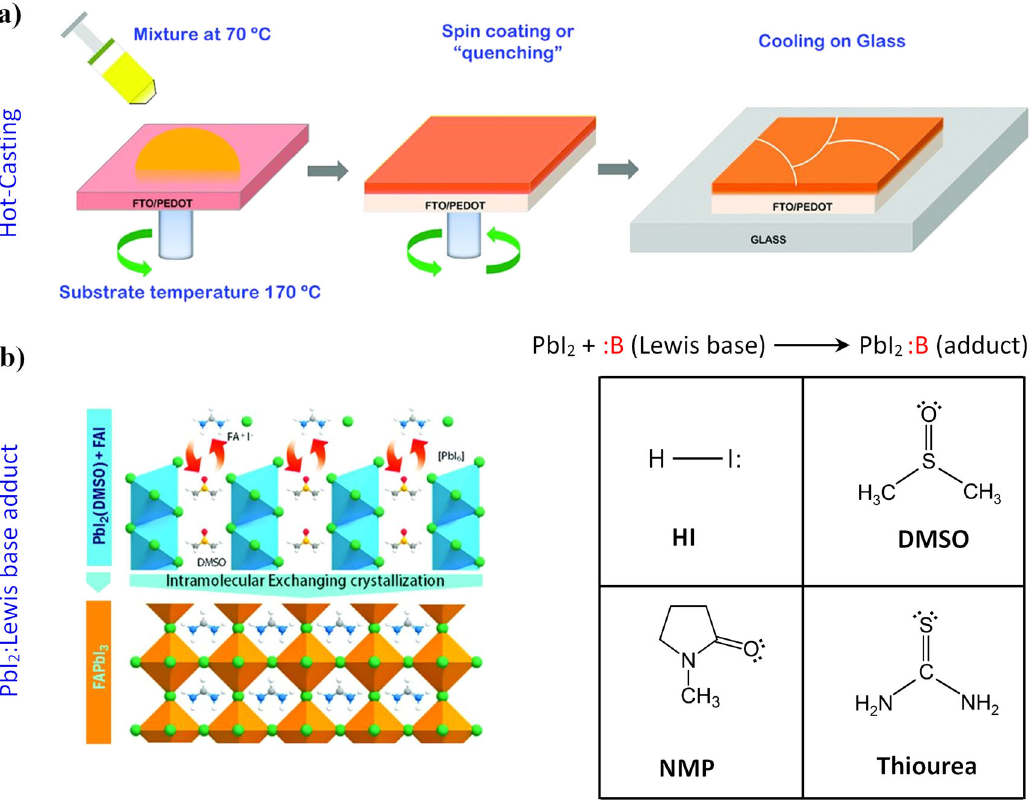
Fig. 2 Increasing the grain size of perovskite fi lms. a Hot-casting scheme for large-area crystal growth. 136 b Schematic the preparation of perovskites by the formation of PbI 2 -Lewis base adduct (left) and some typical Lewis bases for the adducts (right).